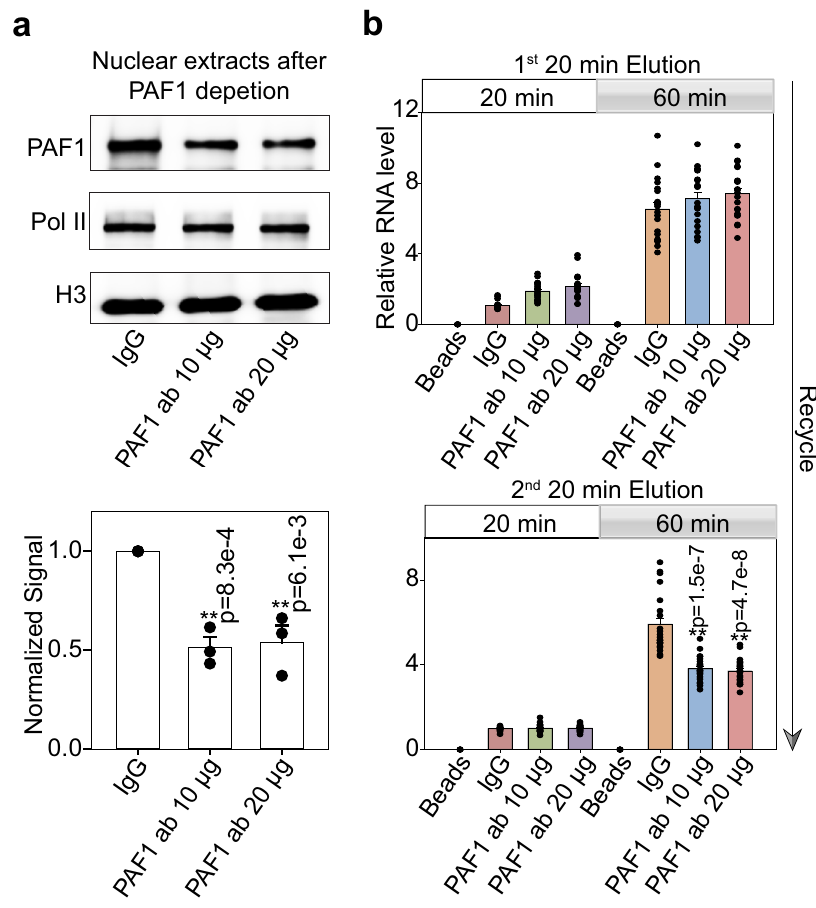
Fig. 3 PAF1 depletion attenuates transcriptional recycling in vitro. a Nuclear extracts from LNCaP-abl cells were incubated with PAF1 antibodies to moderately deplete PAF1 protein, and then were analyzed by western blot. Histone H3 was used as an endogenous loading control. The graph shows the quanti fi cation of PAF1 expression. Values are expressed as the mean ± SEM of three independent experiments. b The transcription recycling assay was performed using nuclear extracts with or without PAF1 depletion. In vitro transcribed RNA products from the 2nd template during the Recycle step were analyzed by reverse transcription followed by qPCR quanti fi cation. Values were expressed as the mean ± SEM of three independent experiments. p -values were calculated using two-tailed Student ’ s t -test, ** p < 0.01. Source data are provided as a Source data fi